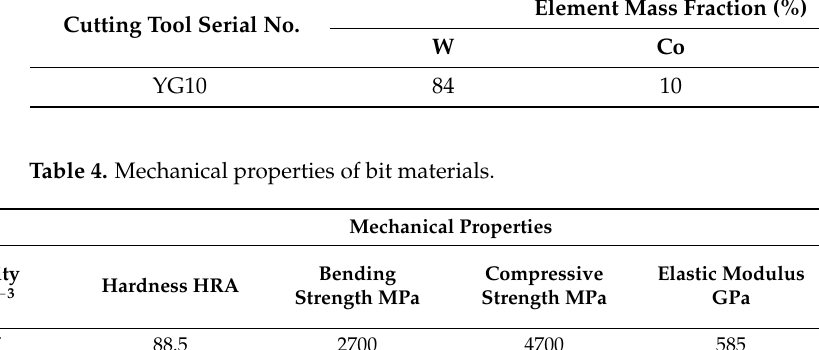
Table 3. Mass fraction of each element in the drill. Cutting Tool Serial No.